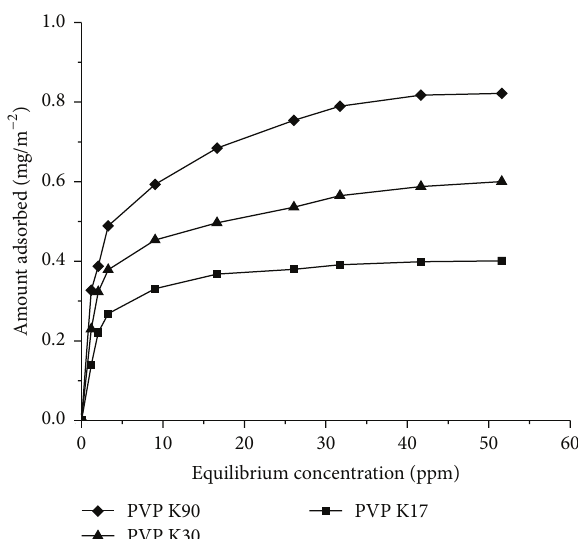
Figure 7: Adsorption isotherms of PVP having different molecular mass on AEROSIL OX 50, measured at 298 K. The error percentage was about